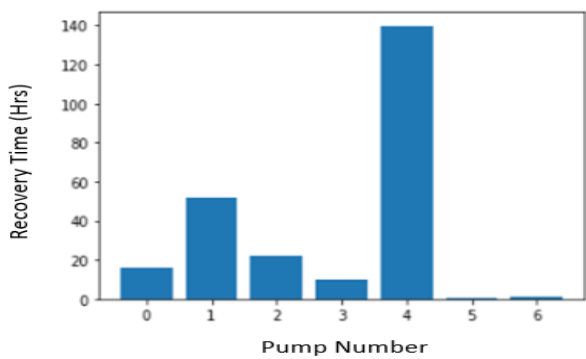
Figure 6. Pump failure status.